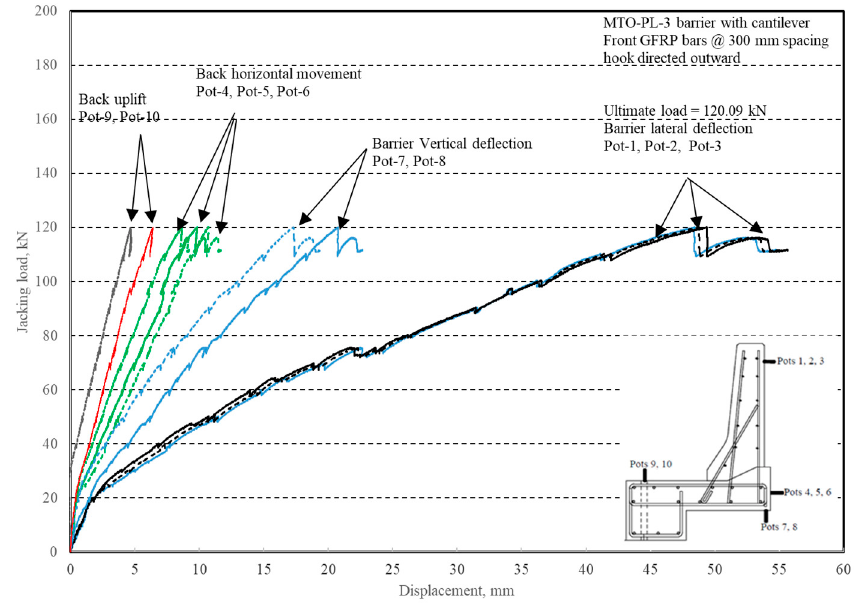
Figure 15. Specimen # 2: Load vs. displacement history.